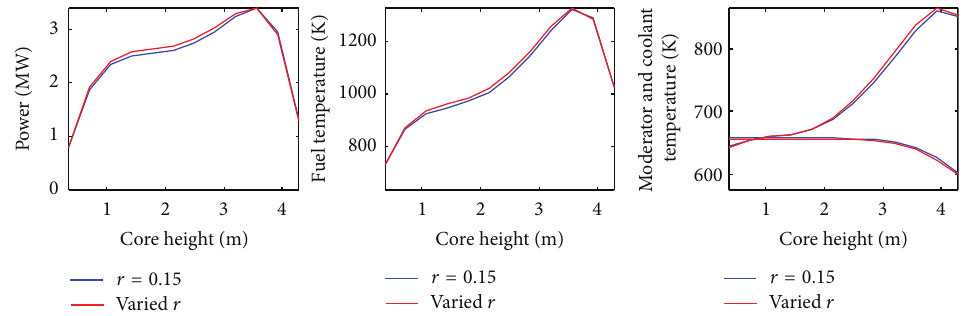
Figure 6: Power, fuel temperature and moderator, and coolant temperature in hot channel in varied 𝑟 case and 𝑟 = 0.15 case.